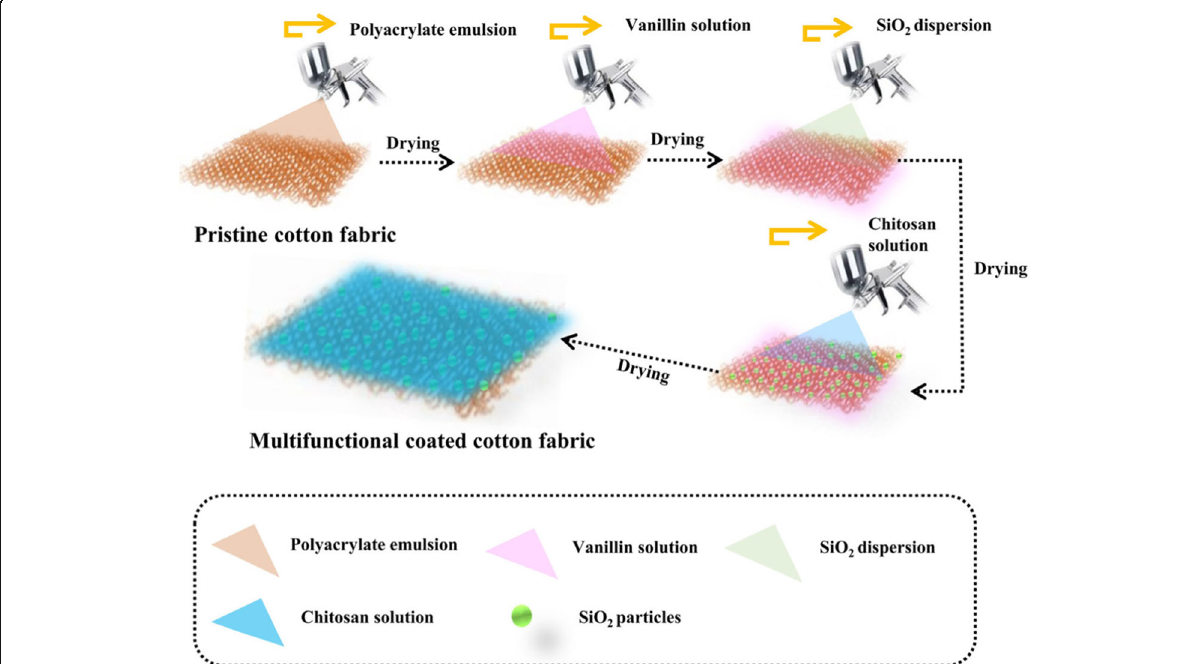
Fig. 8 Illustration for fabrication of the sustained aromatic coatings on cotton fabrics [65]. Copyright 2018,